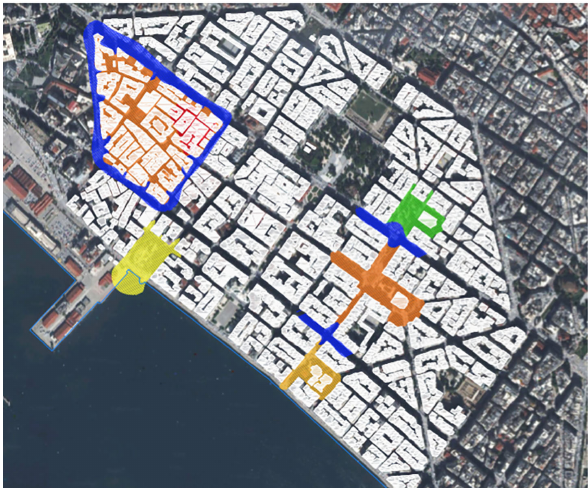
Figure 1: Sound Identity Map in Thessaloniki city center, 2015